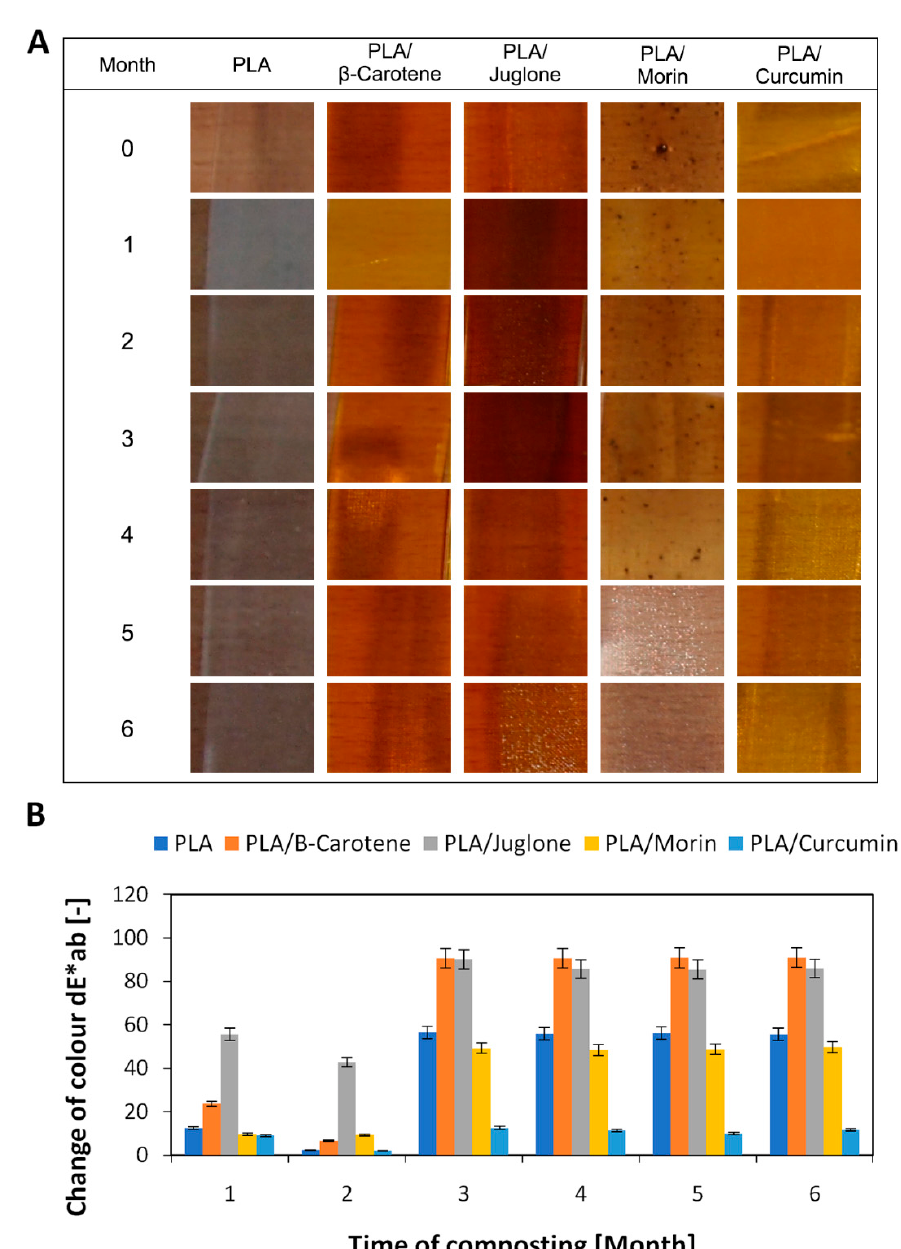
Figure 3. Visual changes of PLA samples ( A ) over 6 months of composting, confirmed by spectrophotometric determination of changes of color ( B ) in CIE-Lab space system.